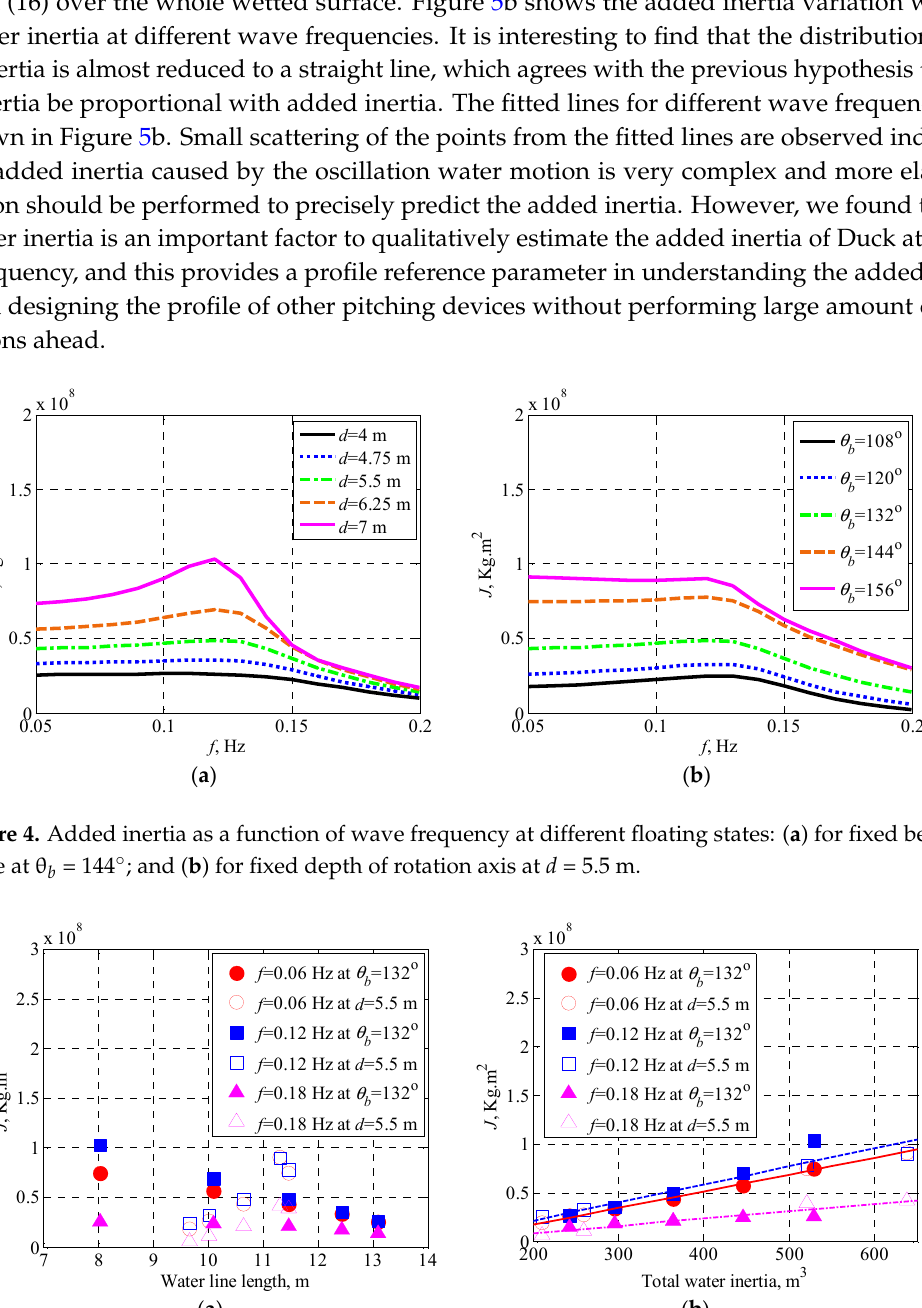
Figure 5. Added inertia variation with characteristic parameters of the wetted surface of the Duck at different wave frequencies: ( a ) for water line length; and ( b ) for total water inertia. The red solid line, blue dashed line and magenta dash-dot line denote the fitted lines at f = 0.06, 0.1 and 0.16 Hz, respectively.